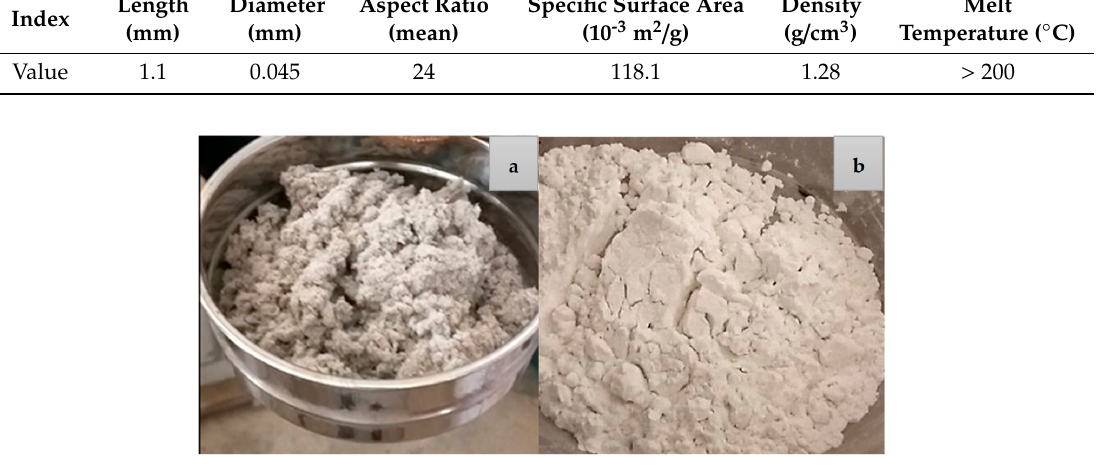
Table 5. Fundamental characteristics of diatomite. Figure 2. ( a ) View of lignin fiber; ( b ) diatomite. Figure 2. ( a ) View of lignin fiber; ( b ) diatomite.